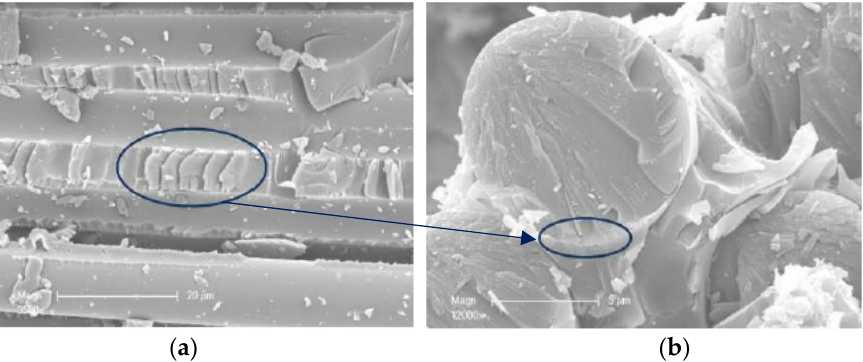
Figure 8. SEM images shows the effect of fibre sizing ( a ) surface ridges and ( b ) fibre matrix inter- face.